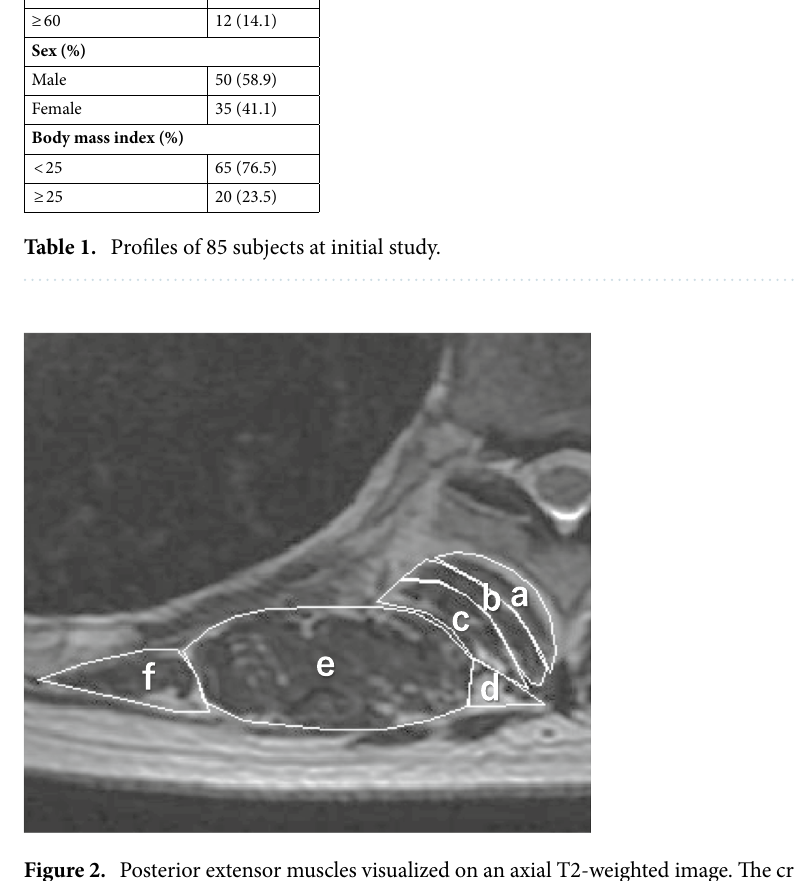
Figure 2. Posterior extensor muscles visualized on an axial T2-weighted image. The cross-sectional area of the transversospinalis muscles (a, rotatores; b, multifidus; c, semispinalis), erector spinae muscles (d, spinalis; e, longissimus; f, iliocostalis) were measured by using the calibrated scale on the MR